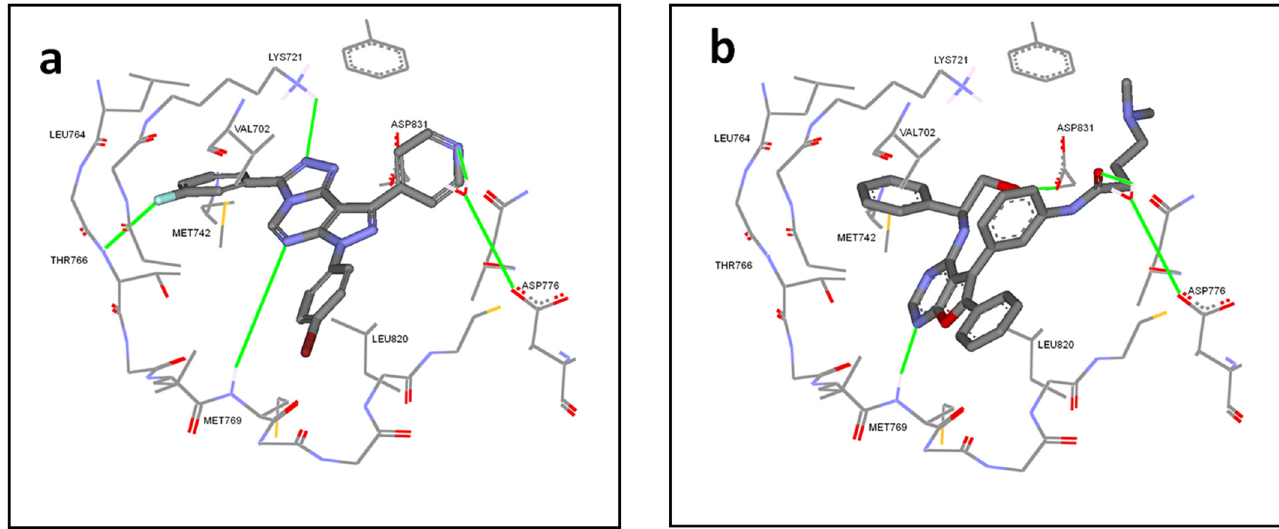
Figure 5. Detailed view of the docked poses of pyrazoltriazolopyrimidine derivative 1 ( a ) in the ATP binding site of EGFR showing hydrogen bonding with key amino acids compared with the co-crystallized ligand ( b ). Hydrogen bonds are indicated by green lines.